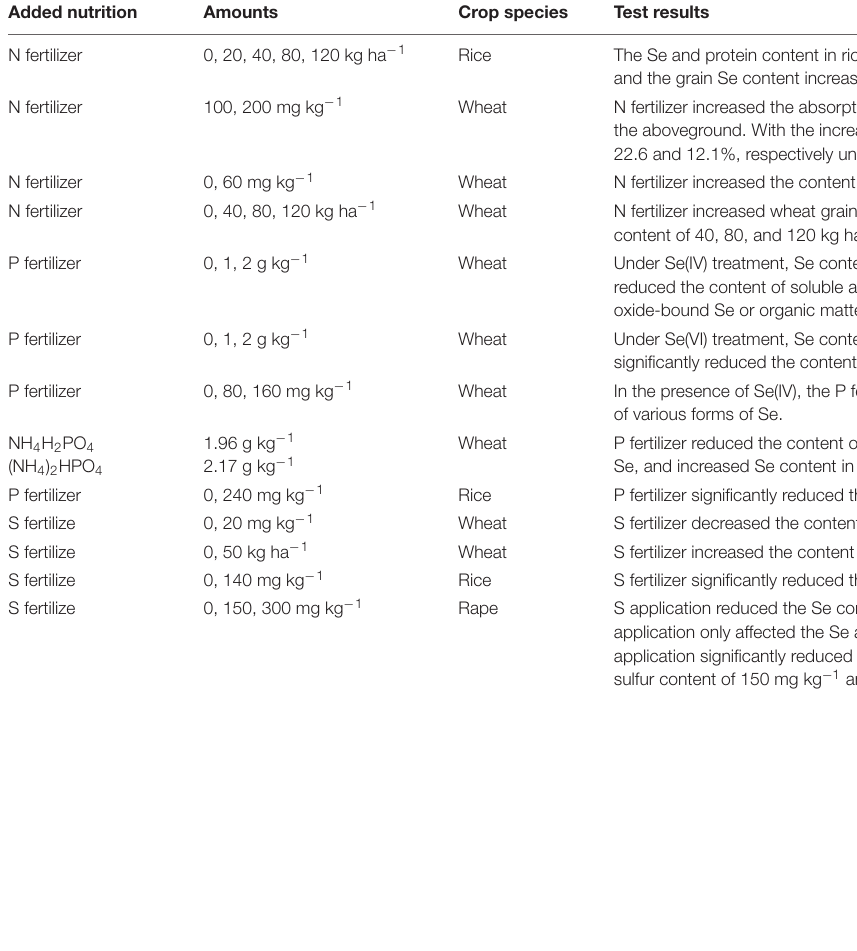
TABLE 2 | Research progress on the effects of nutrient elements on Se accumulation in higher plants. Added nutrition Amounts The Se and protein content in rice grain increased with the increase of N application, and the grain Se content increased from 0.03 mg kg − 1 to 0.35 mg kg − 1 . Wheat N fertilizer increased the absorption of Se (VI) in wheat root and the migration of Se to the aboveground. With the increase of N fertilizer, the Se content in grain increased by 22.6 and 12.1%, respectively under the treatment of low and high Se. N fertilizer increased the content of wheat grain Se.